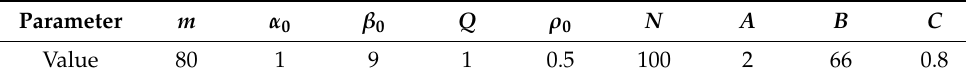
Table 2. Initial parameter setting of the algorithm.